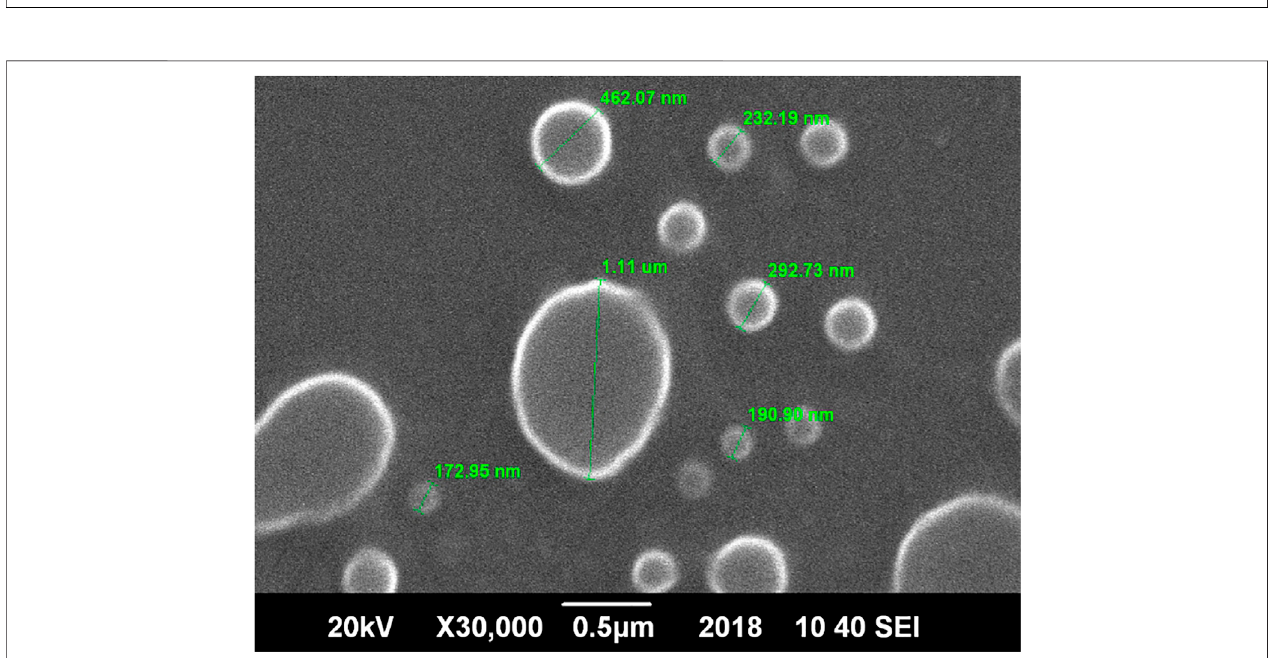
FIGURE 2 | FTIR spectra of herbal ethosomes.